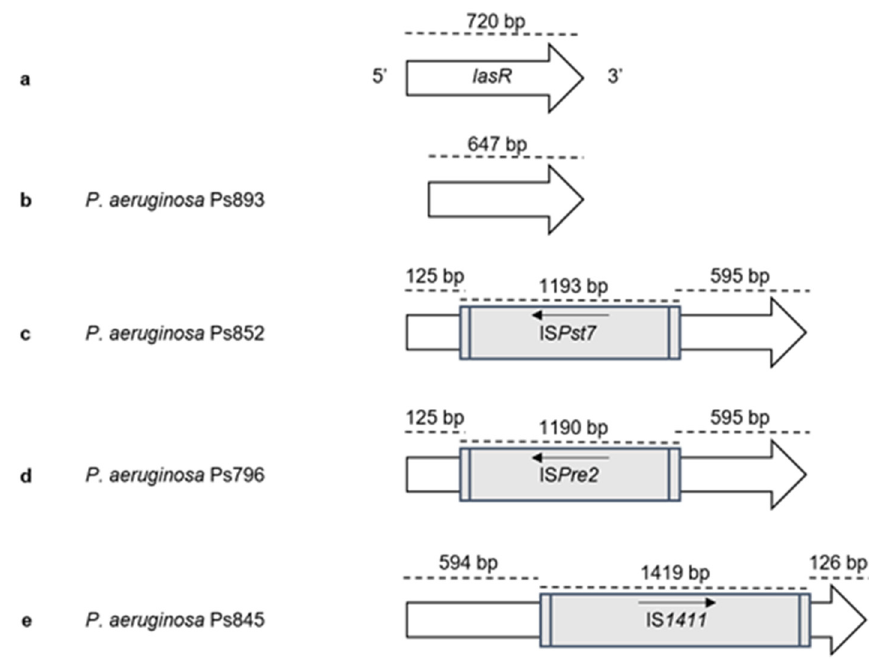
Figure 2. Representation of truncated lasR genes found among our P. aeruginosa strains. The position and orientation of the gene and insertion sequences are indicated by arrows: ( a ) lasR gene (PA1430) of the control strain P. aeruginosa PAO1 (NCBI accession number NC_002516); ( b ) Ps893 strain, lasR size is 647 bp due to the presence of a deletion at the beginning of the gene; ( c ) Ps852 strain, lasR truncated at position 125 bp by the insertion sequence IS Pst7 (1193 bp) (GenBank accession number MH050331); ( d ) Ps796 strain, lasR truncated at position 125 bp by the insertion sequence IS Pre2 (1190 bp) (GenBank accession number MH050329); ( e ) Ps845 strain, lasR truncated at position 595 bp by the insertion sequence IS 1411 (1419 bp) (GenBank accession number MH050330).